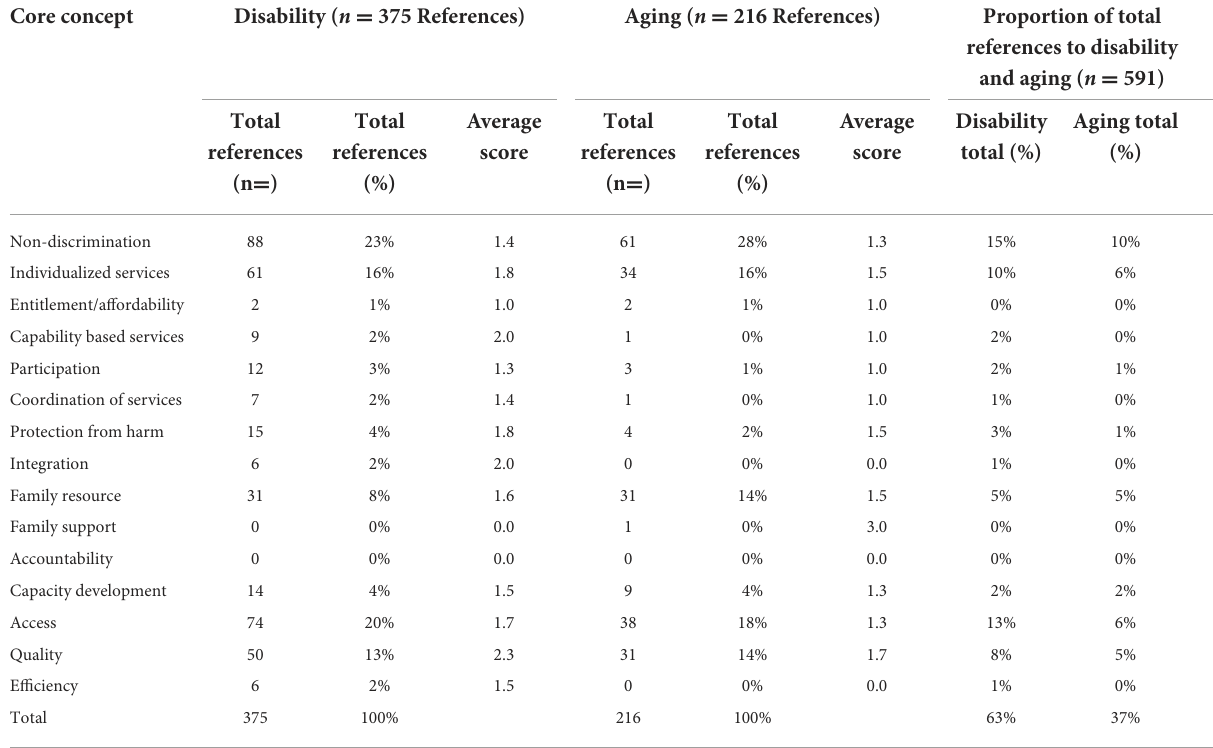
TABLE 4 Frequency of references to core concepts and average scores across all documents, and the comparison between disability and